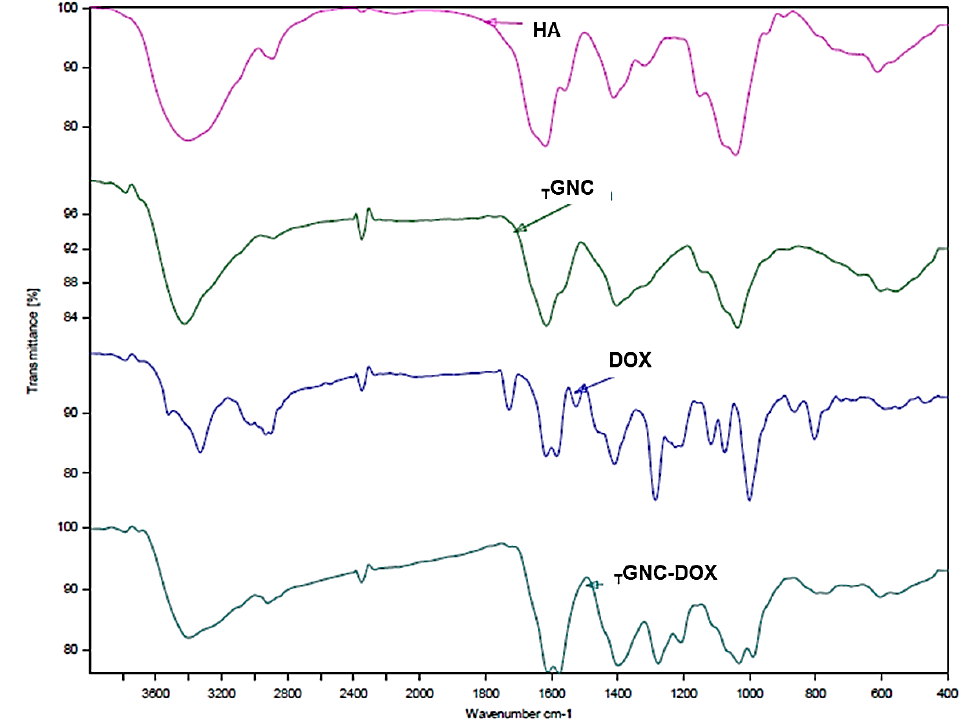
Figure 3. FTIR spectra of HA, T GNC, DOX, and T